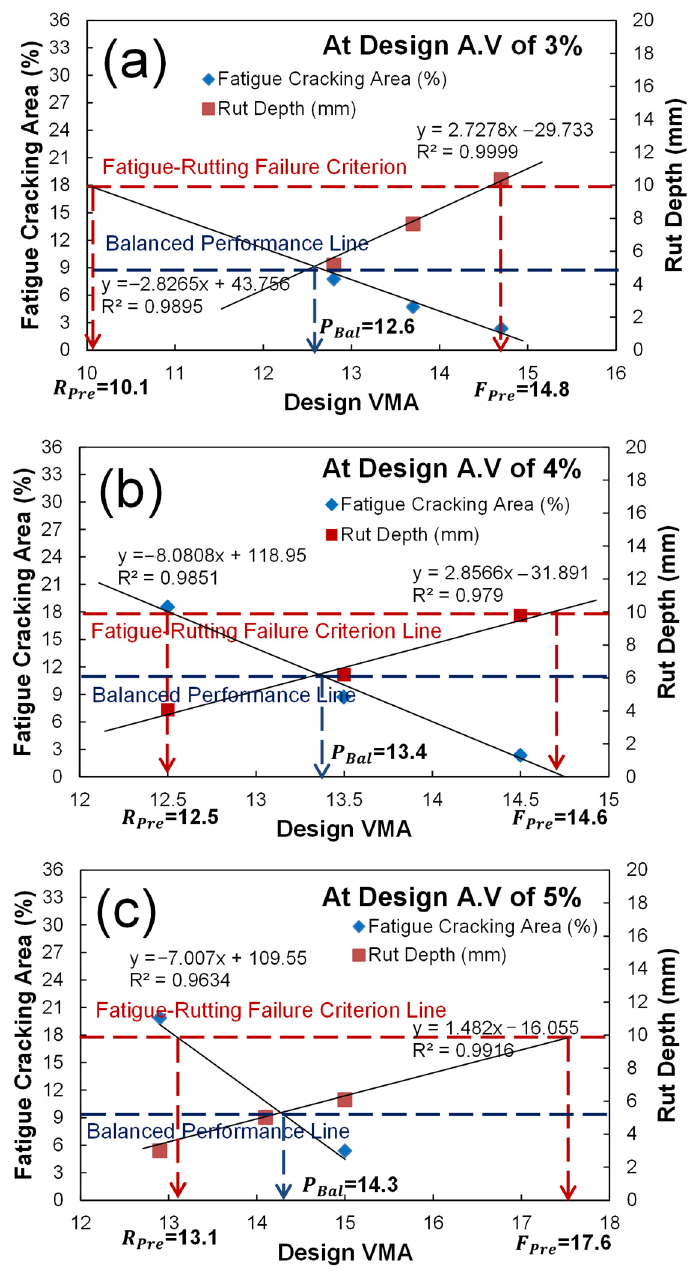
Figure 17. Results of the performance criteria and volumetric AQC targets of fatigue-preferred, rutting-preferred, and performance-balanced mix designs: ( a ) air void 3%; ( b ) air void 4%; ( c ) air void 5%.